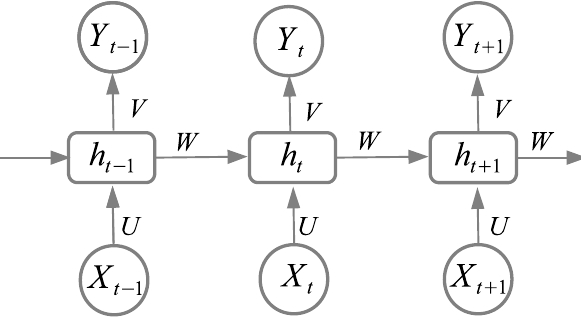
Figure 4. A simple RNN, with one layer of hidden